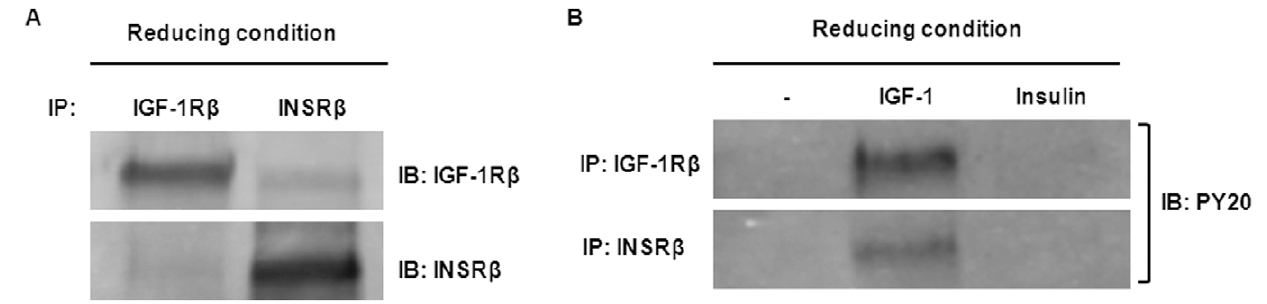
Figure 3. IGF-1 activates the IGF-1R/INSR hybrid. (A) Existence of IGF-1R and INSR ab -dimers after reducing immunoprecipitation. hTCEpi lysates were reduced with DTT to break the receptors into ab -dimers. Reduced lysates were then immunoprecipitated with rabbit polyclonal anti-IGF- 1R b (CST # 3027) or anti-INSR b (C-19). Top panel : Immunoblot of INSR b immunoprecipitates from reduced lysates with anti-IGF-1R b showed no or faint bands corresponding to the IGF-1R b . Bottom panel : Immunoblot of IGF-1R b immunoprecipitates from reduced lysates with anti-INSR b showed no or faint bands corresponding to the INSR b . (B) Activation of IGF-1R and INSR in hTCEpi cells by IGF-1 stimulation. Protein lysates of hTCEpi cells after stimulation by IGF-1 (100 ng/ml) or insulin (100 ng/ml) for 15 min were collected and reduced by DTT and then subjected to reducing IP. IGF-1, but not insulin, induced phosphorylation of IGF-1 receptor ( Top panel ) and insulin receptor ( Bottom panel ) detected on immunoblots with anti-PY20.